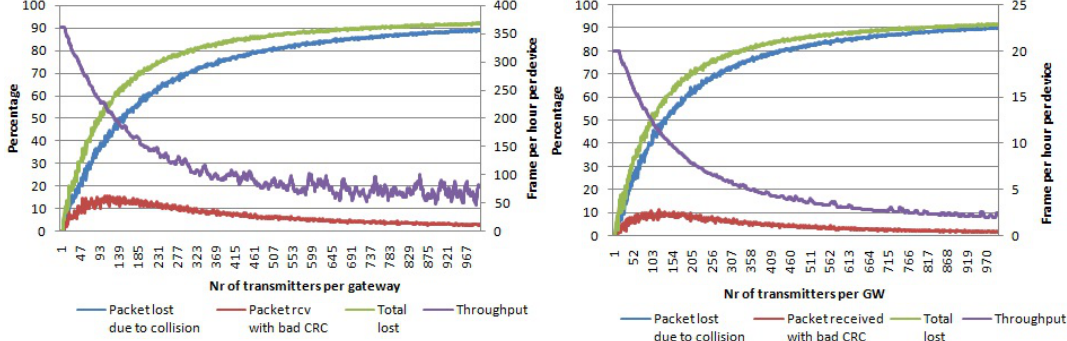
Figure 6. Percentage of packets lost due to collisions and percentage of packets received with the wrong payload CRC per number of transmitters per gateway. Average throughput per device. Single channel, single SF and payload size 20 bytes. ( left ) Using SF 7; ( right ) using SF